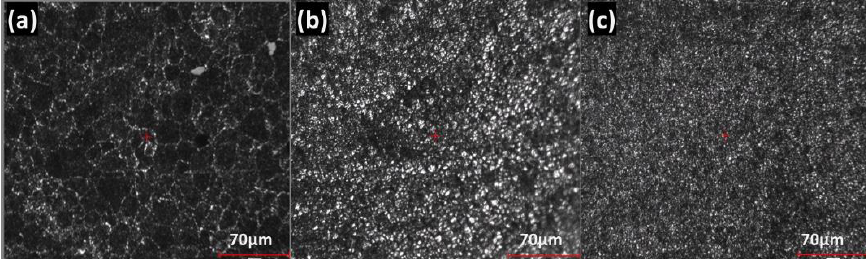
Figure 9. The effect of passes number on the microstructure refinement at rotation speed 900 rpm